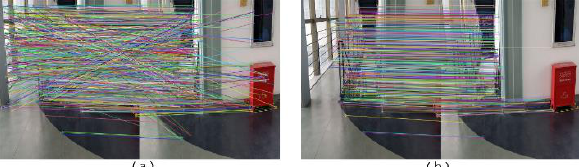
Fig.1 The results of image matching. (a) SIFT. (2) our algorithm